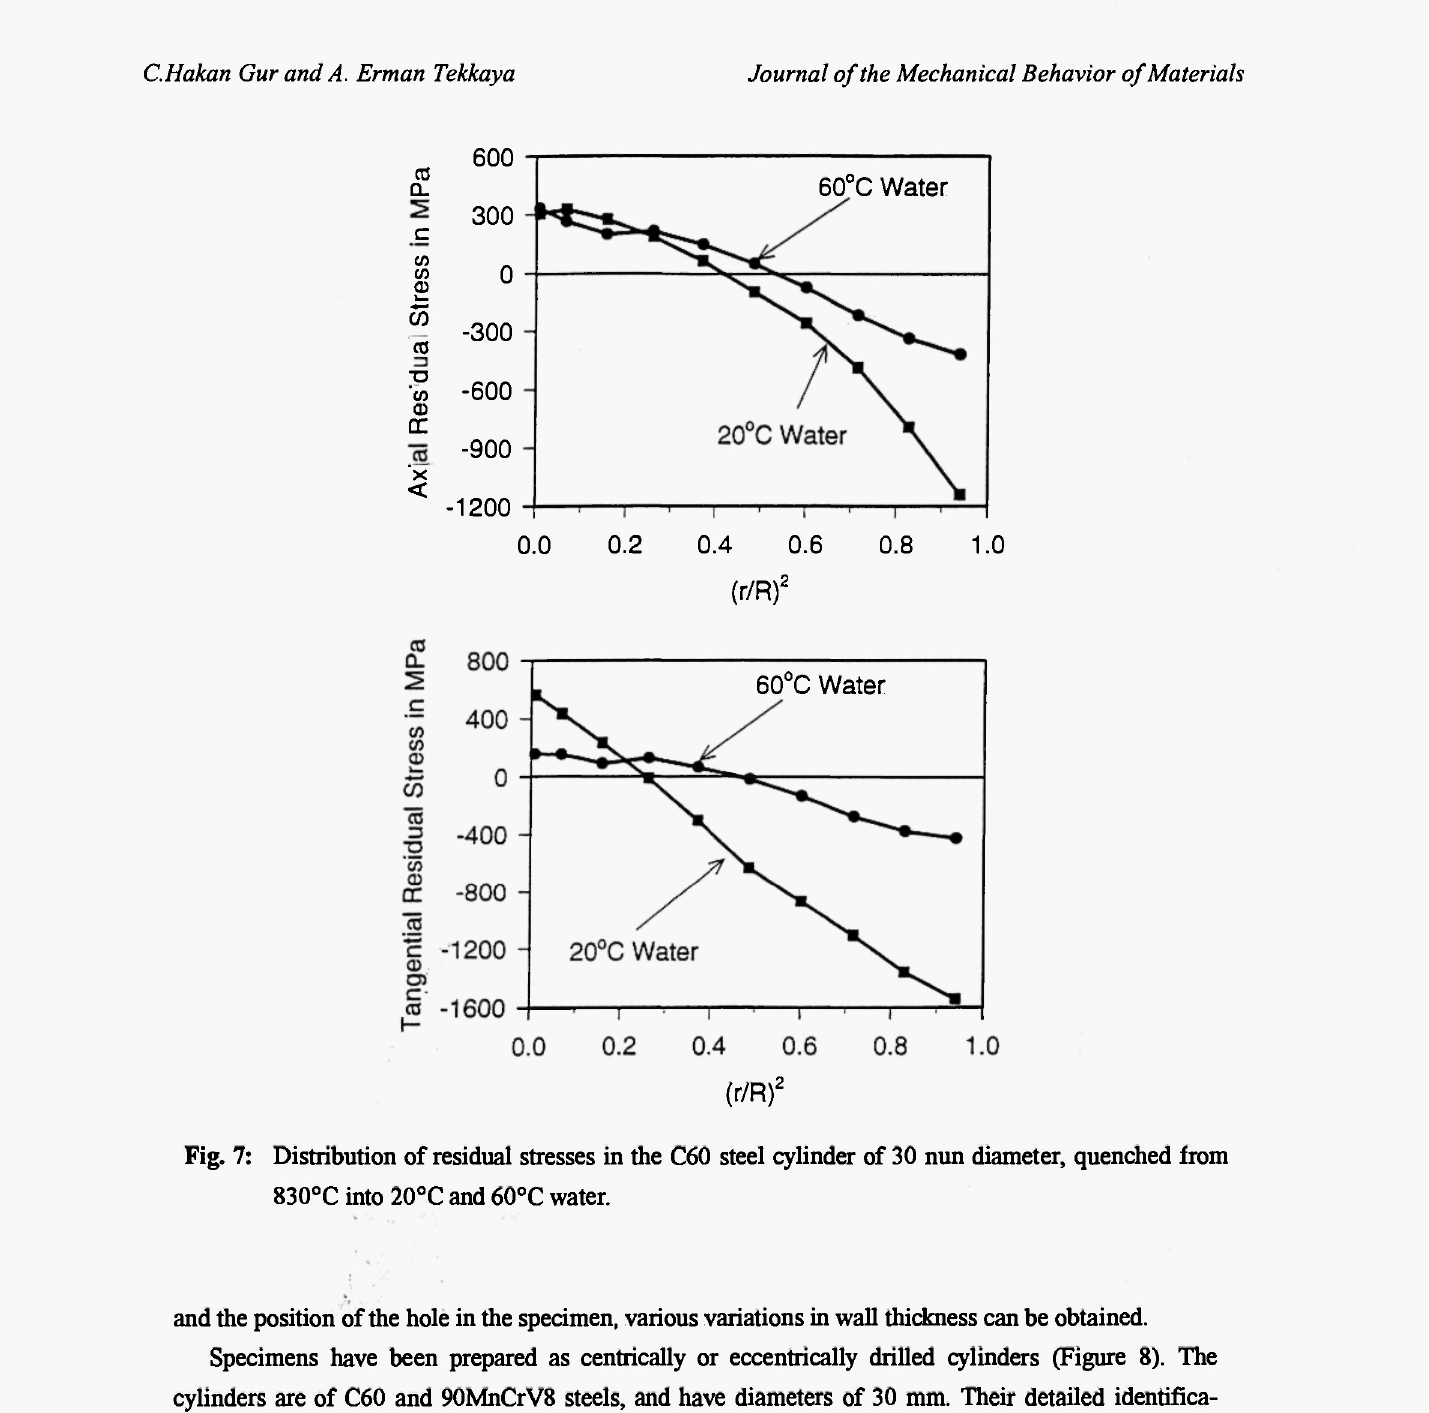
Fig. 7: Distribution of residual stresses in the C60 steel cylinder of 30 nun diameter, quenched from 830°C into 20°C and 60°C